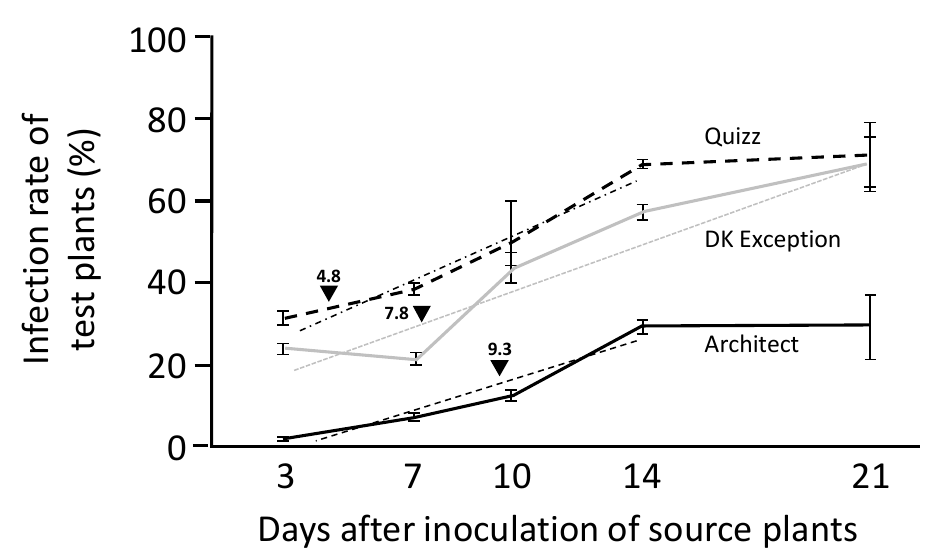
Figure 3. Transmission efficiency associated to source plants infected by TuYV for 3 to 21 days. Series of 8 plants (cvs. Architect, Quizz, and DK Exception) infected for 3, 7, 10, 14, and 21 days were used as sources for aphid-mediated transmission of TuYV-PS to susceptible cv. DK Exception test plants. Each source plant was used to inoculate ten test plants. Three weeks after inoculation, the presence of TuYV in test plants was tested by ELISA. Evolution of the quality of plants as a source for virus transmission are illustrated for each tested genotype. Linear regressions obtained from data from source plants infected for 3 to 14 days (cvs. Architect and Quizz) and for 3 to 21 days (cv. DK Exception) are drawn. The durations (expressed in days) of infection of source plants required to obtain 50% of the maximum infection rate are presented for each genotype by black triangles. The experimental procedure was repeated 3 times for each genotype. The vertical bars represent the standard deviations associated with the data.